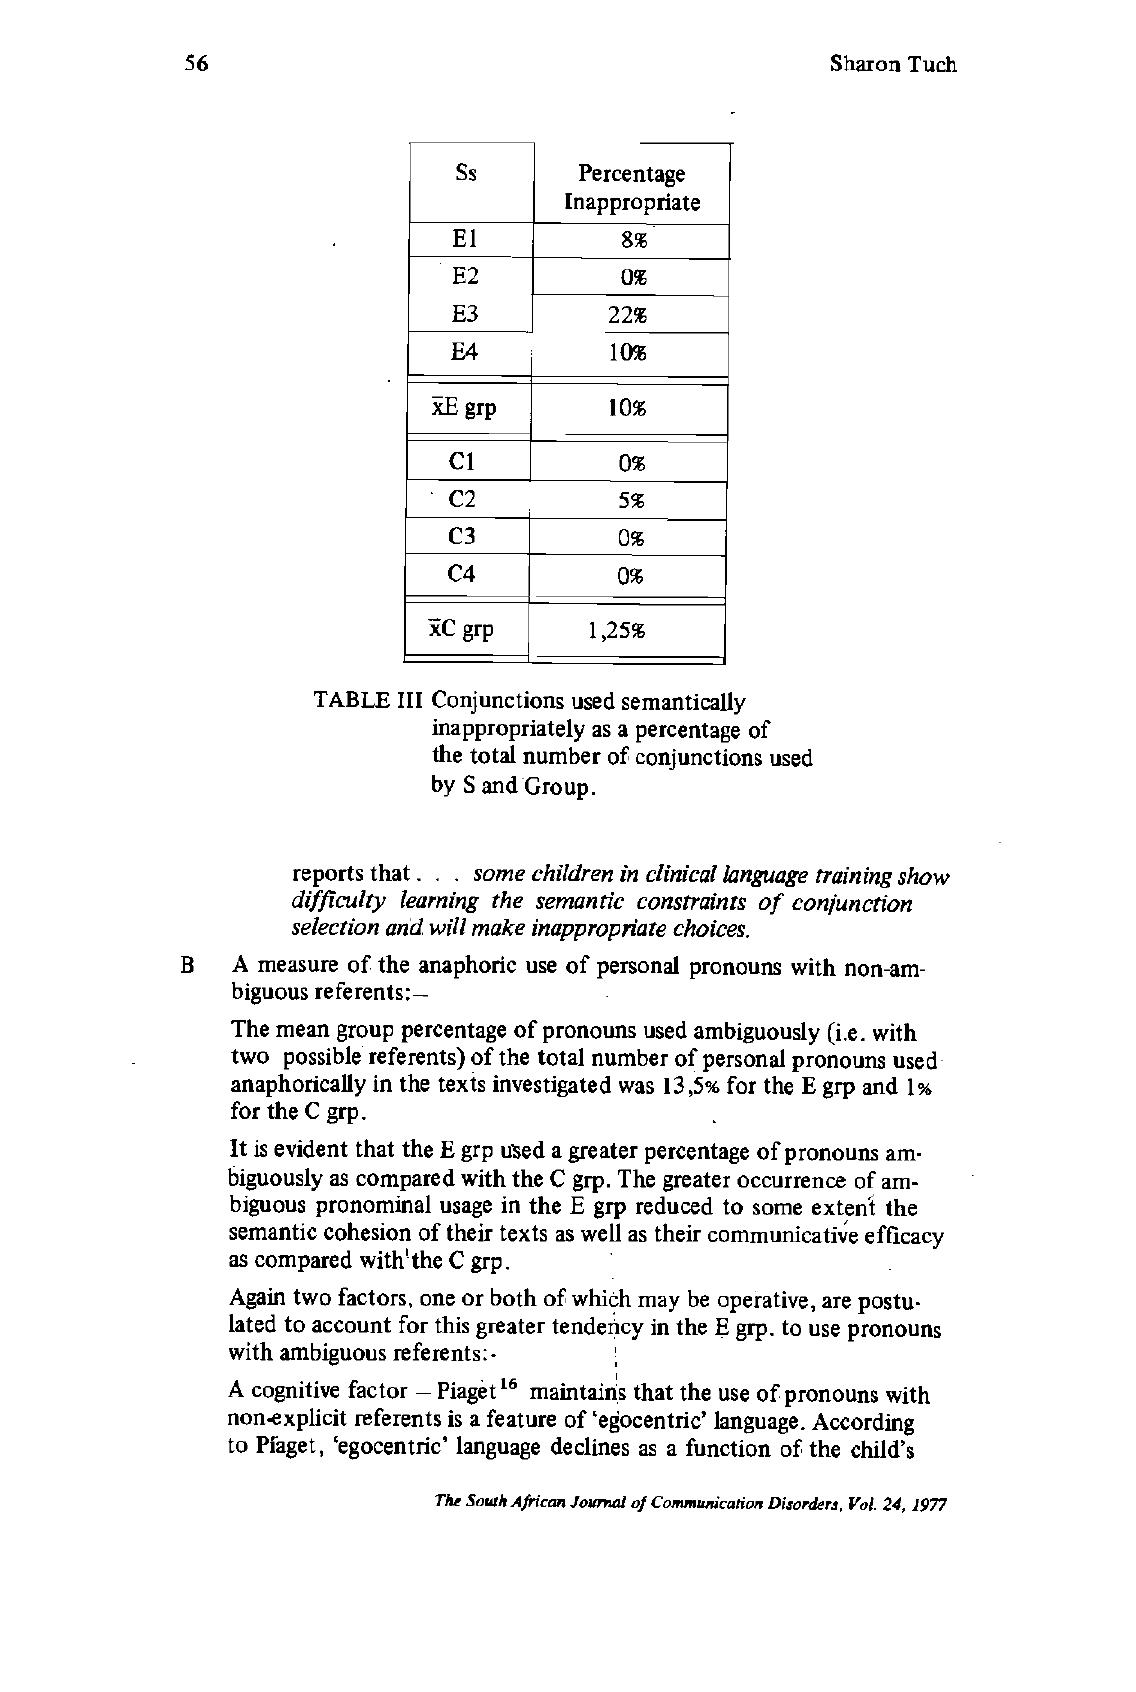
TABLE III Conjunctions used semantically inappropriately as a percentage of the total number of conjunctions used by S and